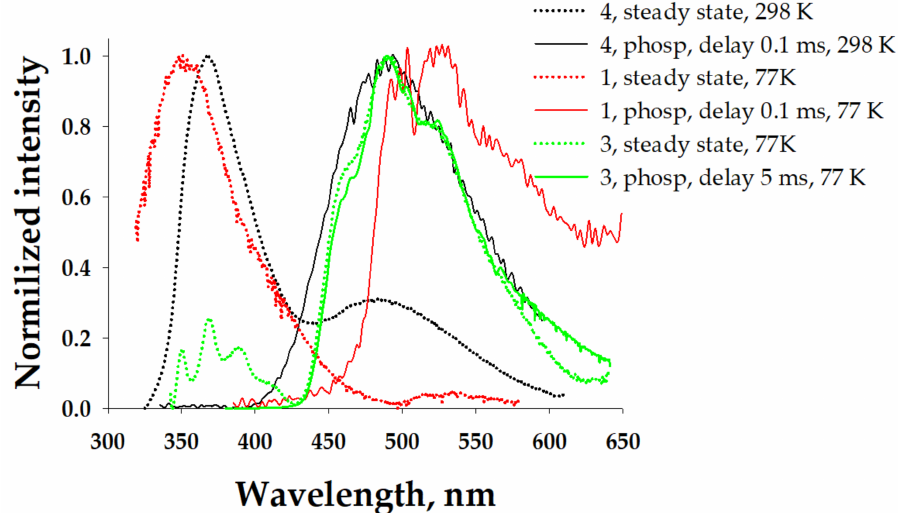
Figure 7. Normalized emission spectra of the solid samples ( λ exc = 305 nm), including steady-state (dotted lines) and phosphorescence spectra (solid lines).